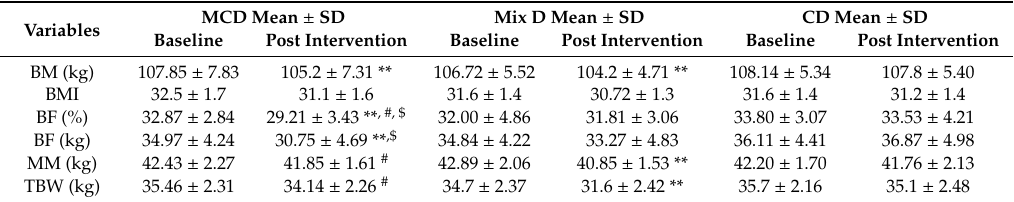
Table 3. Baseline and postintervention body composition results for moderate-carbohydrate diet (MCD), mix diet (MixD), and conventional diet (CD).